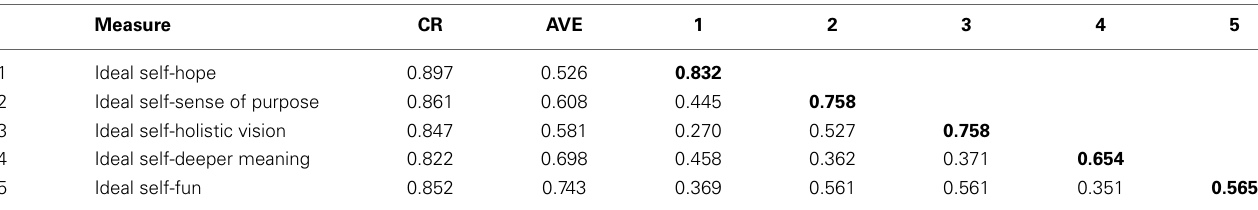
Table 1 | Pilot study measurement model and correlations for the ideal self as a 5-factor scale a . Measure CR AVE 1 1 Ideal self-hope Ideal self-sense of